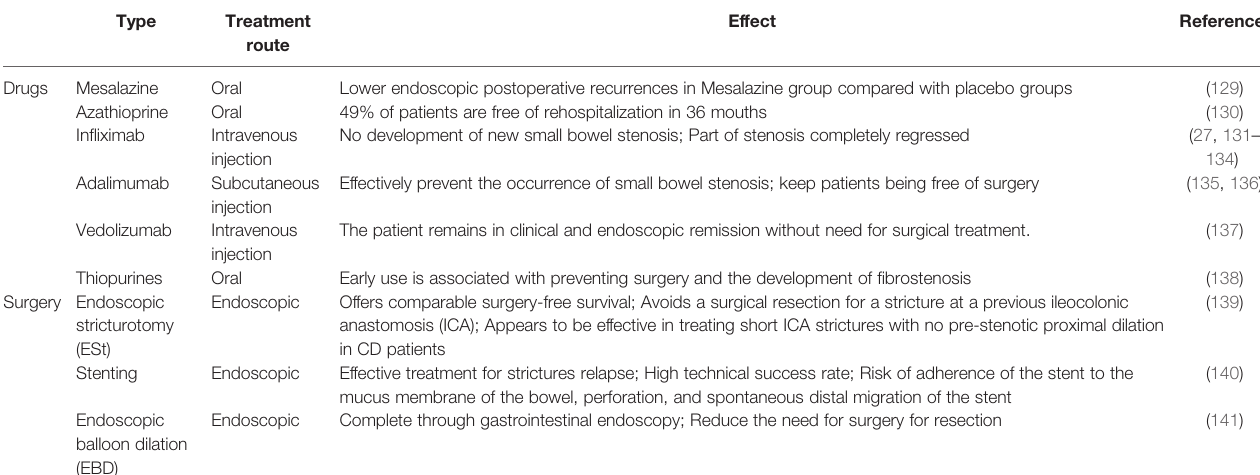
TABLE 2 | Present treatments in IBD-associated fi